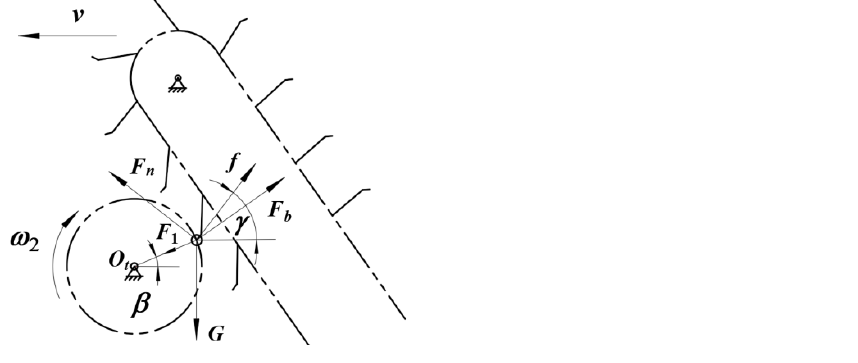
Figure 11. A schematic diagram of the forces on the residual film during the de ‐ filming